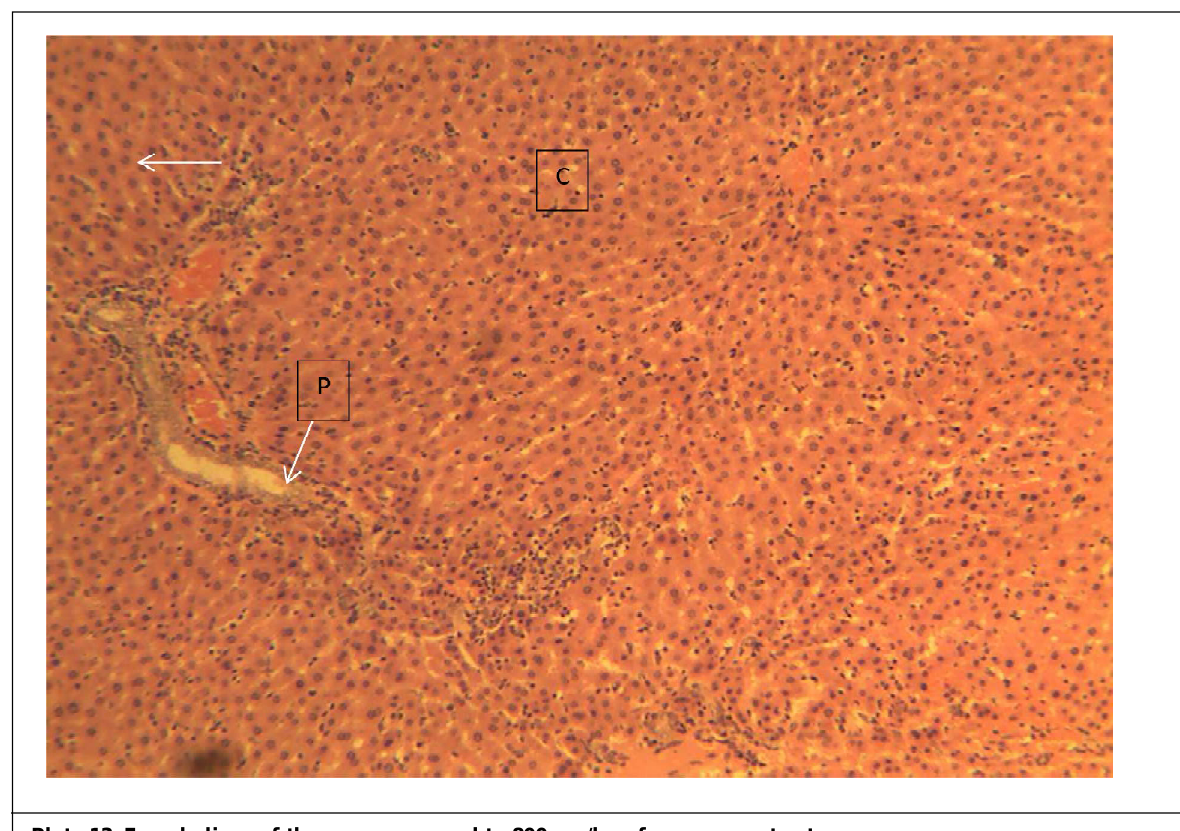
Plate 13: Female liver of the group exposed to 800 mg/kg of aqueous extract